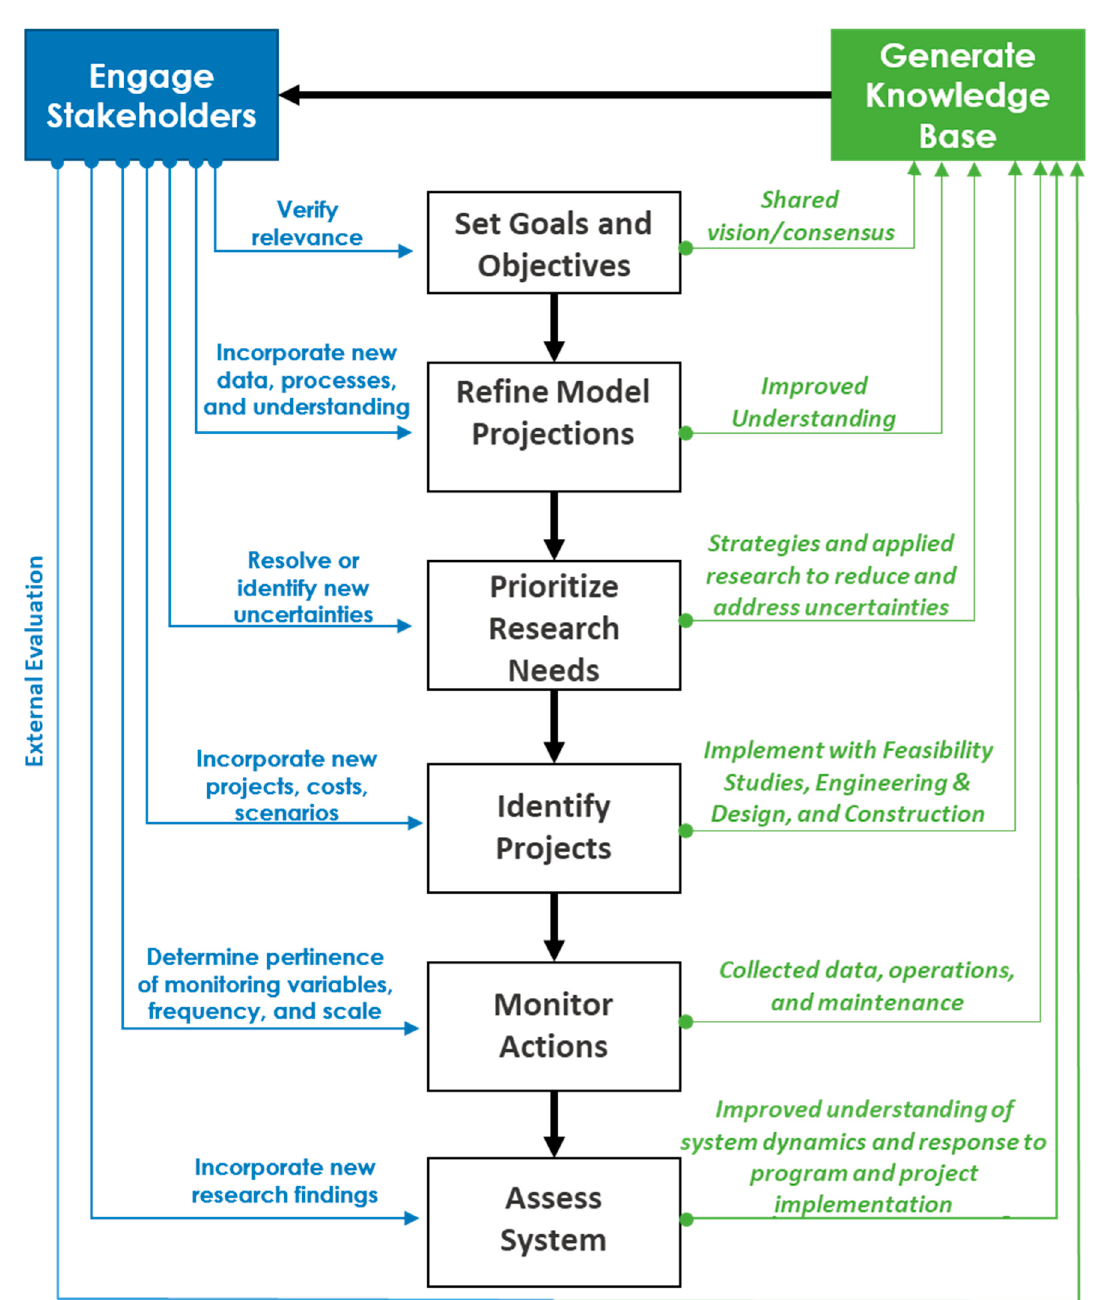
Figure 5. Program and project implementation process used for Louisiana coastal restoration demonstrating how science is incorporated to reduce and address uncertainties. Modified from [82].